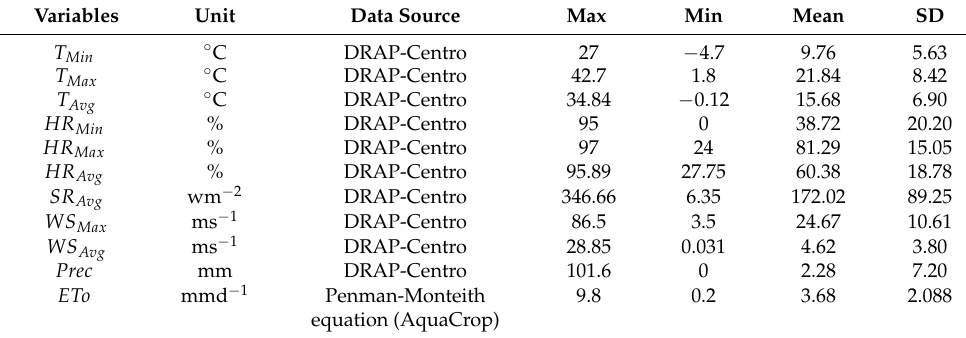
Table 3. Dataset